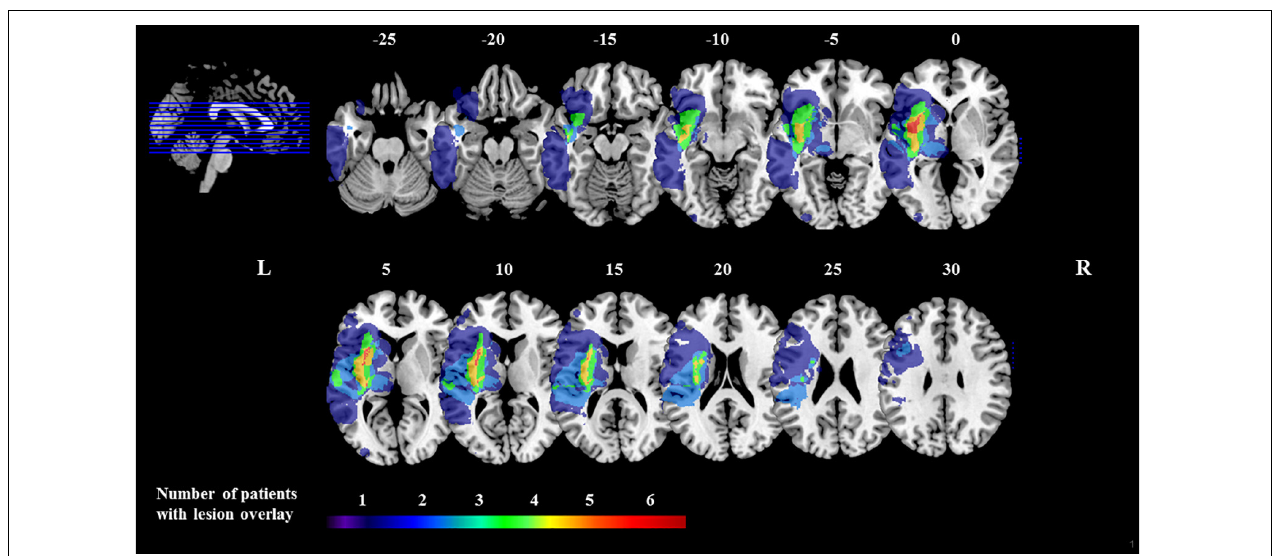
FIGURE 1 | Lesion overlay plot. Brain lesions of all 10 patients with left-hemisphere stroke. The color-coded legend is determined by the number of patients with damage to a specific brain region. Lesion overlap maps are plotted on the CH2bet template available in MRIcron (https://www.nitrc.org/projects/mricron). Axial slices are oriented according to the neurological convention. The z-position of each axial slice, in MNI coordinates, is indicated by the numbers at the top of the respective slices, and also depicted by the blue lines on the sagittal slice (top, left-hand side of the